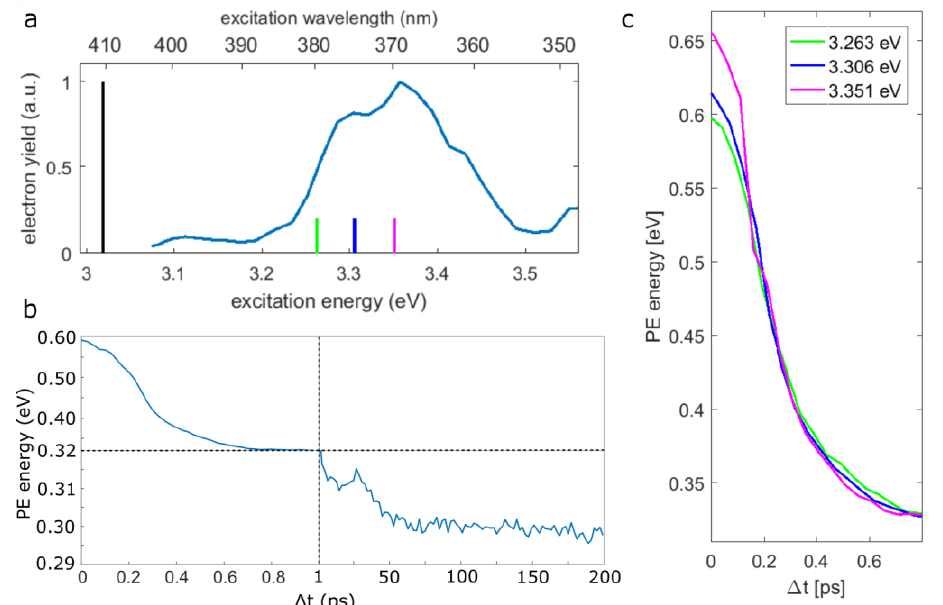
Figure 1: Photoexcitation of the In-He N system in the range of the In 6 𝑆 1/22 ⟵ 5 𝑃 1/22 transition. (a) Excitation spectrum recorded at a fixed pump-probe time delay of 200 ps by scanning the pump photon energy and monitoring the monomer peak of the PE spectrum [2]. The black line represents the bare- atom transition. (b) Transient 6 𝑆 1/22 PE peak position for 3.297 eV excitation energy, determined by fitting Gaussian functions to the PE spectra. (Note that the first picosecond is displayed with higher time resolution and lower energy resolution. (c) Transient PE peak position within the first 800 fs for different photoexcitation energies, as indicated in